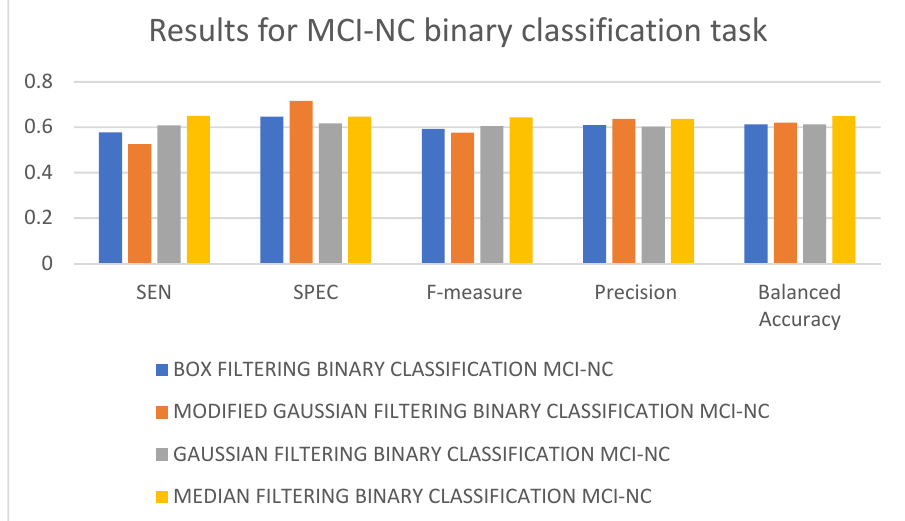
Figure 9. Results of different 3D-CNN architectures for the MCI-NC binary classification task.